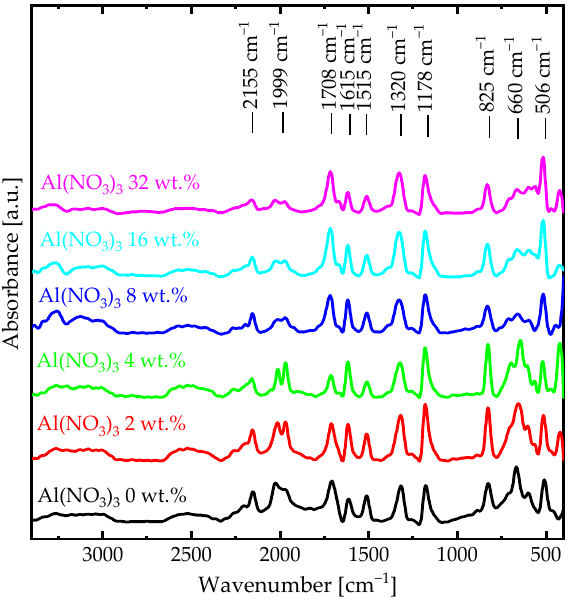
Figure 1. FTIR spectra of (PANI-HCl)/Al(NO 3 ) 3 complex composite films with various Al(NO 3 ) 3 concentrations. Table 1. Vibrational bands of (PANI-HCl)/Al(NO 3 ) 3 complex composite film for different Al(NO 3 ) 3 concentrations.